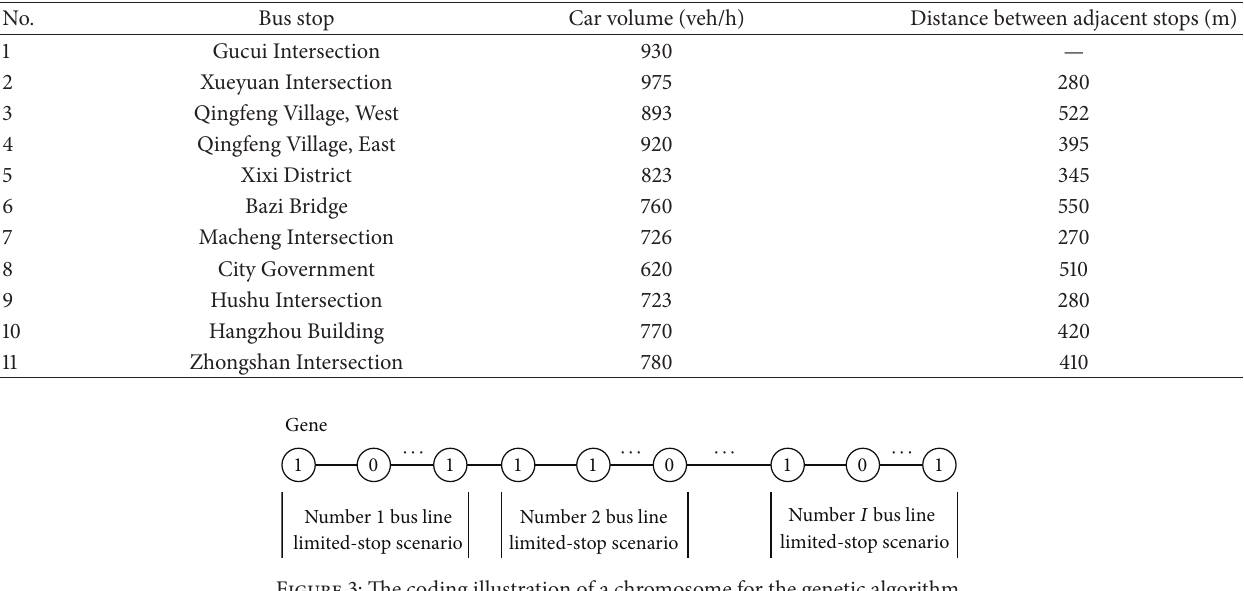
Table 3: Traffic data on Tian-Mu-Shan Road.